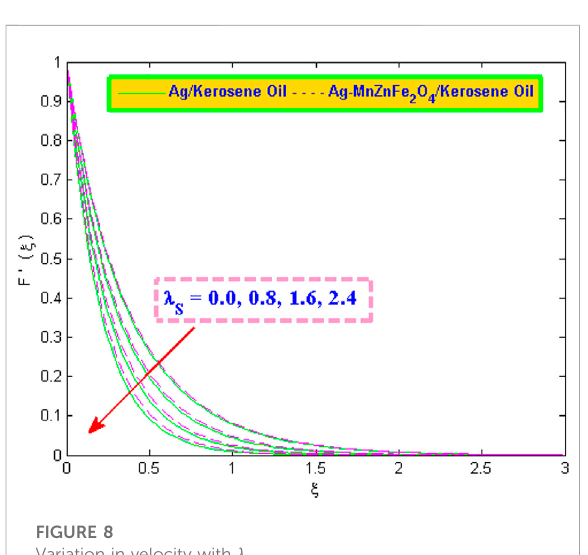
FIGURE 8 Variation in velocity with λ s .